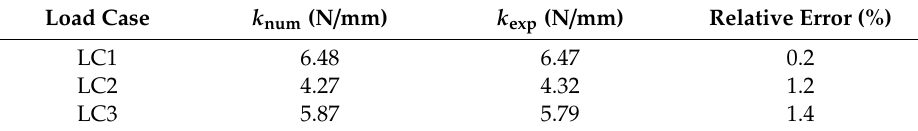
Table 4. Comparison of numerical and experimental sti ff nesses of the composite panel.